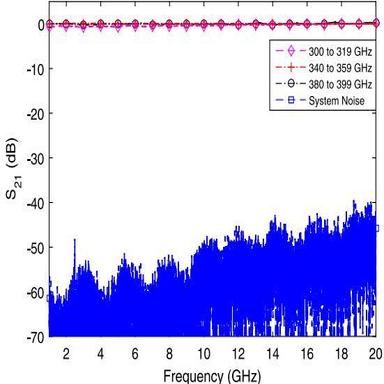
Measurement equipment losses after calibration.